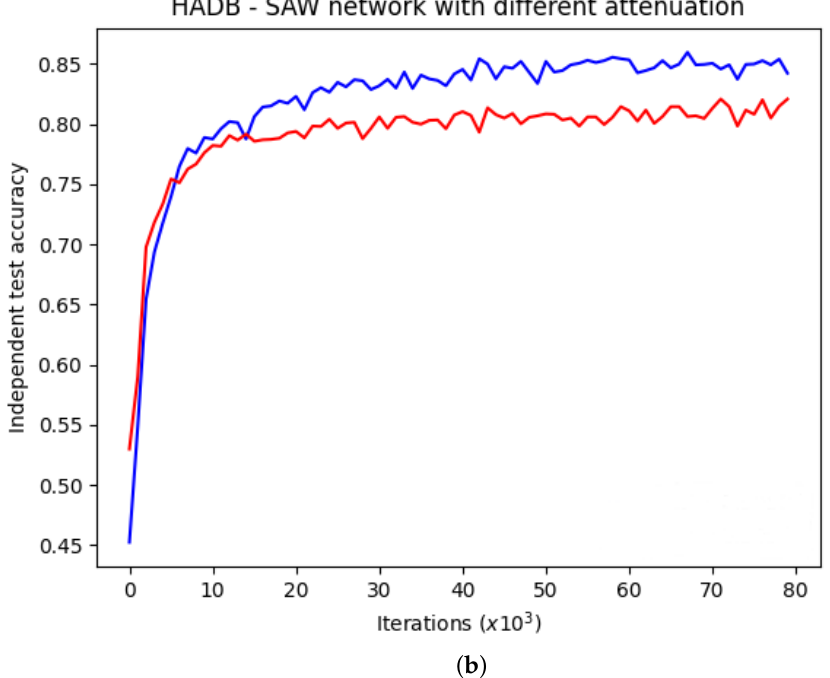
Figure 12. The training results of MNIST ( a ) and HADB ( b ) classification with different a (attenuation) parameters. In case of the blue curves, the a is 9999, and the red curves show the result for it being